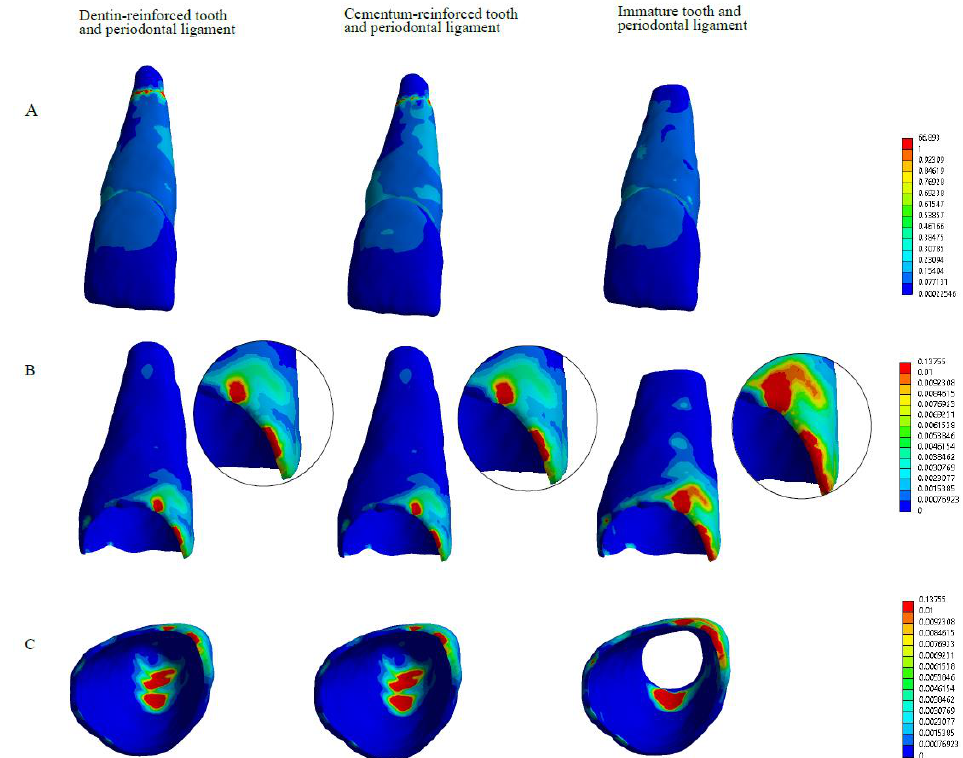
Figure 3. Stress distribution in the tooth ( A ) and in the periodontal ligament ( B , C ) of Models 1, 2 and 3 in mesial load scenario. Similar stress patterns are observed between all tissues of Models 2 and 3. Maximum tensile stress of the teeth ( A ) and ligaments ( B , C ) are coloured in